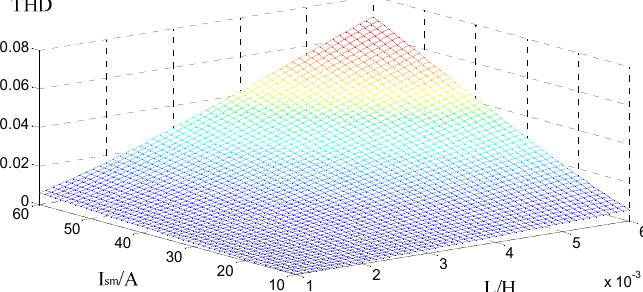
Figure 11. Three-dimensional (3D) diagram of current total harmonic distortion (THD) under a unity power factor.